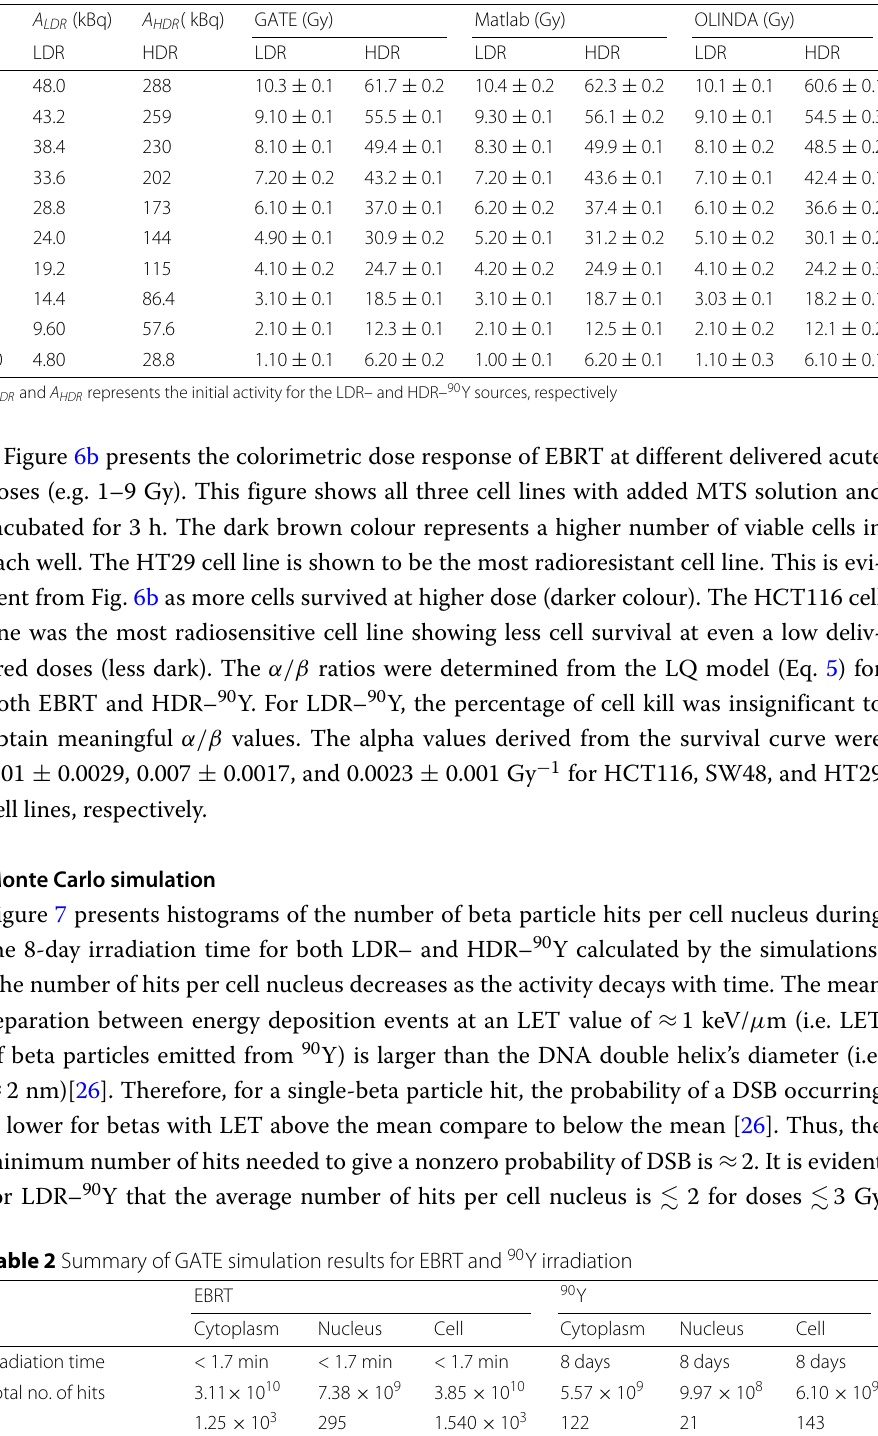
Table 1 Summary of dose calculations for HDR and LDR– 90 Y activities